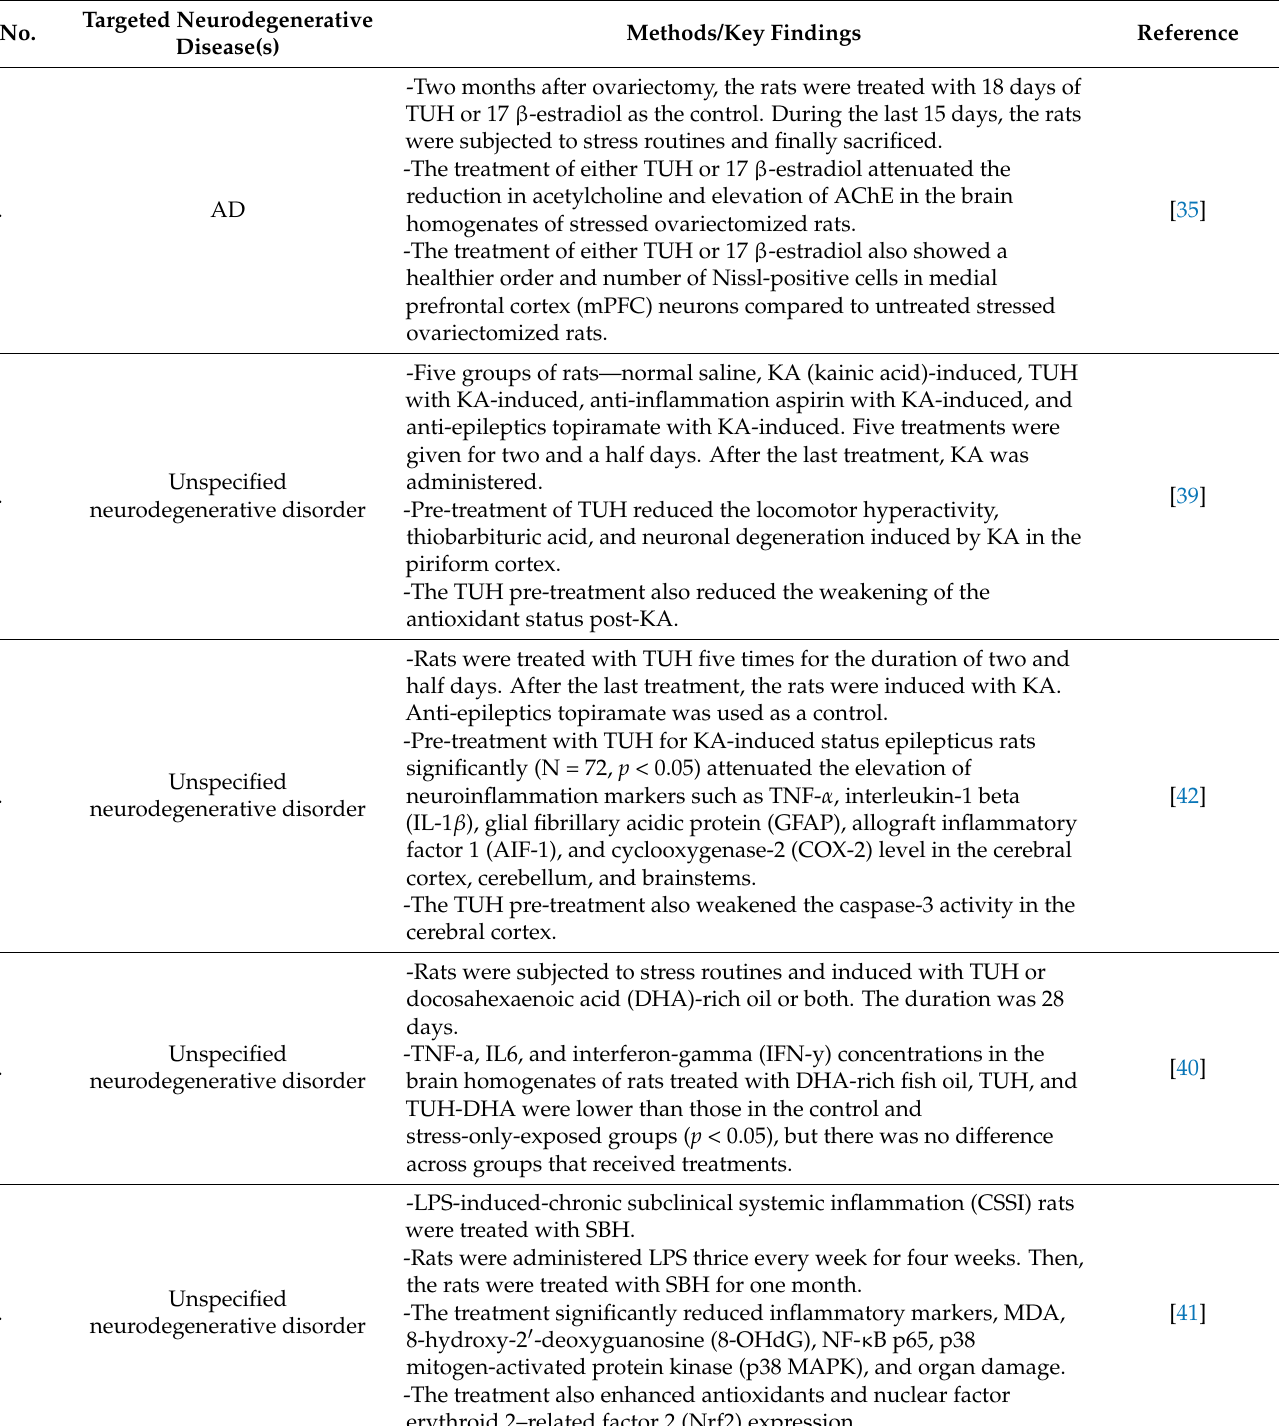
Table 2. In vivo studies on using honey for the therapy of neurodegenerative diseases.